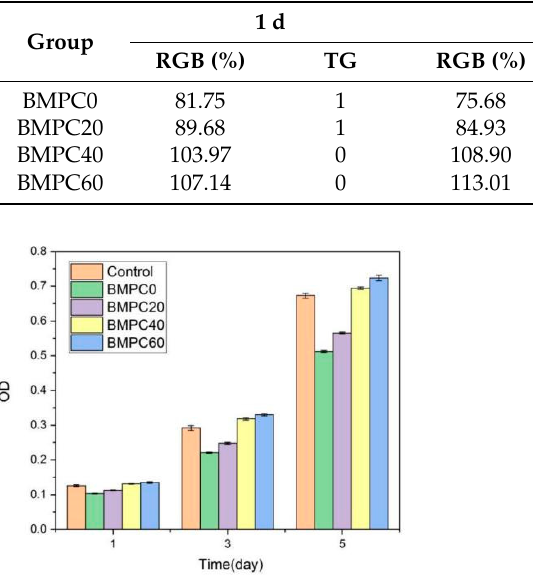
Figure 7. The cytotoxicity of BMPC samples.